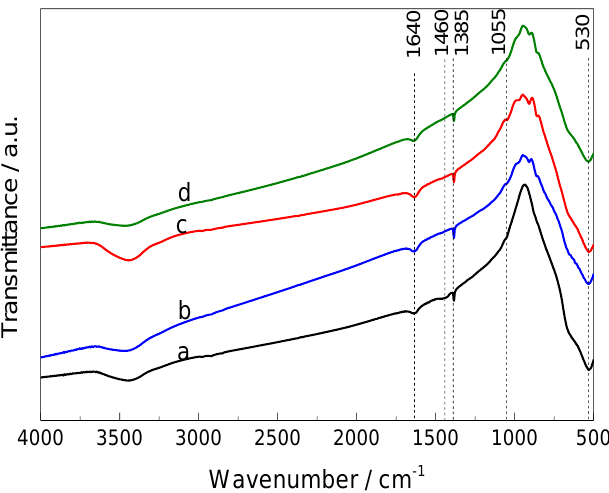
Figure 3. FTIR spectra of BaTiO 3 ceramics: BTO ( a ), BTO_1 ( b ), BTO_2 ( c ), and BTO_3 ( d ) in the 500–4000 cm − 1 range.